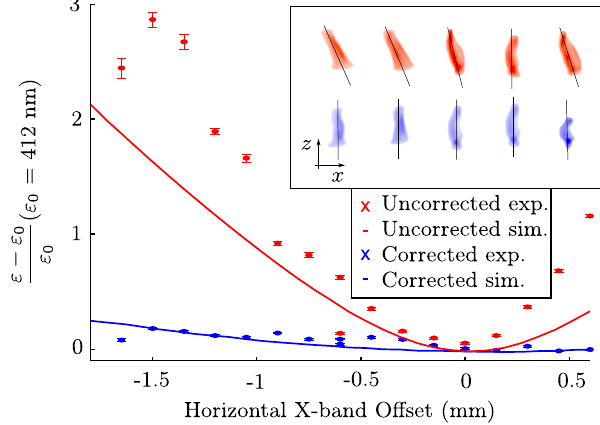
FIG. 10. Corrected (blue) and uncorrected (red) beam tilts generated by transverse wakefields due to offsets of the X -band cavity. The inlet shows the measured particle distributions for different phase advances for a measurement of the beam tilt. plane.FIG. 8. Genesis simulations for the SwissFEL large bandwidth The main figure represents the relative growth of the projected ¼ 1 Å for an uncorrected (red) and corrected mode at λ photons emittance in simulation and measurement. (blue) distribution. Left: photon energy along the undulator line. Right: photon power along the pulse at the undulator exit. Bottom: Spectrum of the photon pulse at the undulator